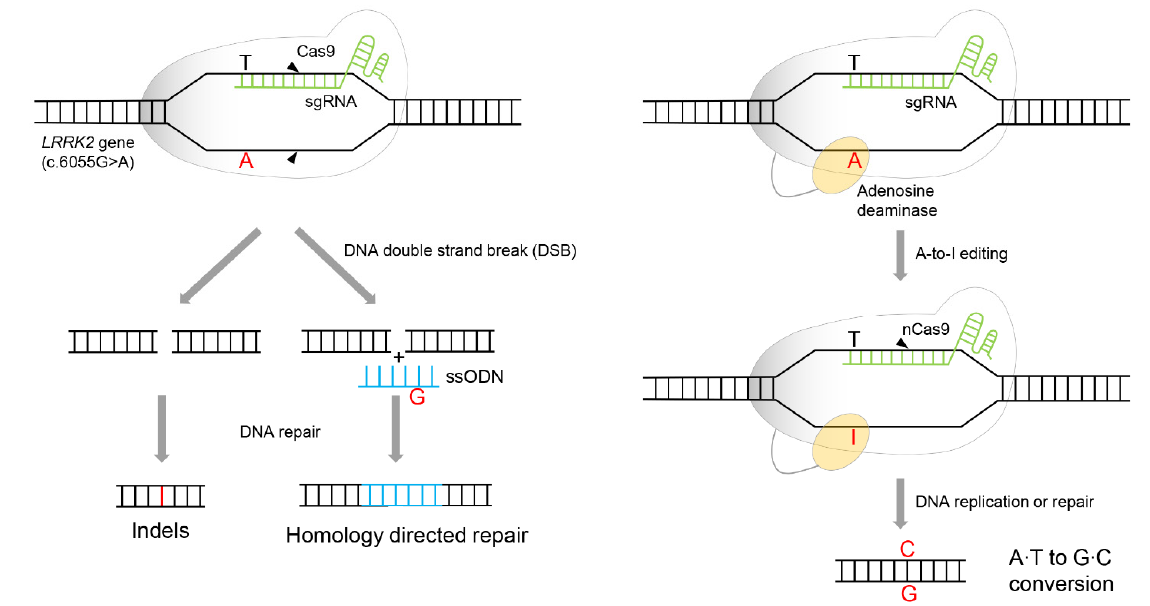
Figure 6. ABE-mediated LRRK2 gene targeting compared to CRISPR/Cas9. CRISPR/Cas9-homology-directed repair ( left ) and ABE system ( right ). nCas9 means Cas9 nickase harboring D10A mutation. sgRNA indicates single guide RNA, including a targeting sequence and a Cas9 or adenosine deaminase-recruiting sequence. ssODN means single-stranded oligodeoxynucleotide served as DNA donor template. A; adenosine, T; thymidine, G; guanosine, C; cytidine, I; inosine. In LRRK2 gene-corrected clones, α -synuclein phosphorylation and kinase activity by autophosphorylation of LRRK2 in the LRRK2 G2019S mutant cells was reduced. As